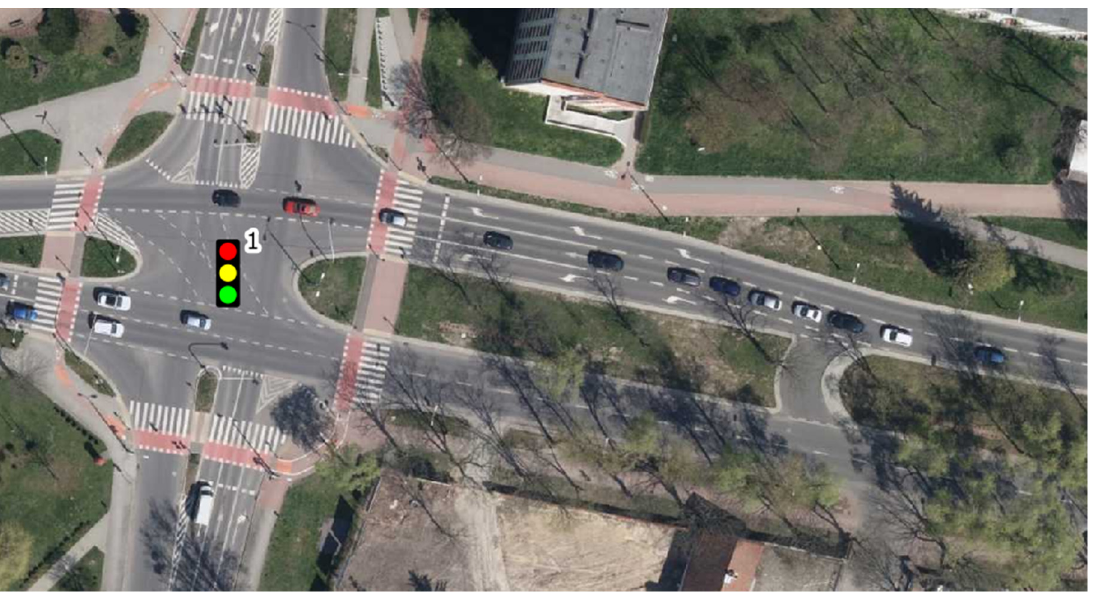
Figure 3. Traffic organization at intersection No. 1. (Background map Head Office of Geodesy and Cartography). During measurements at the intersection, signaling programs with a cycle duration of 100 s (06:30–08:00) and 95 s (08:00–08:30) operated. The green signals had a time of 36 s